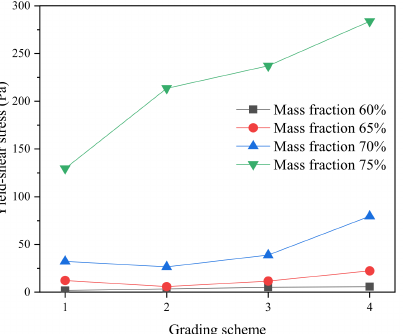
Figure 7. Effect of particle size grading distribution on yield shear stress.